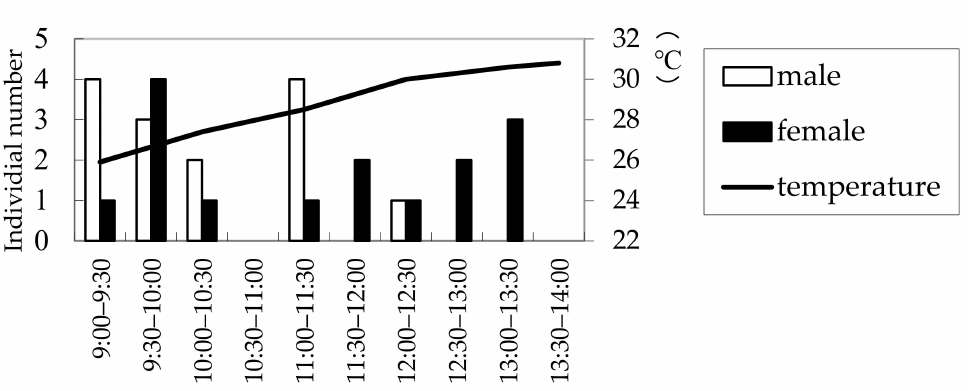
Figure 4. Numbers of Rosalia batesi adult individuals observed in the suburban forested area in Onojimachi, Machida, Tokyo Pref., Japan. (16 July 2008). Males appeared significantly earlier than females (Mann–Whitney U test, p <